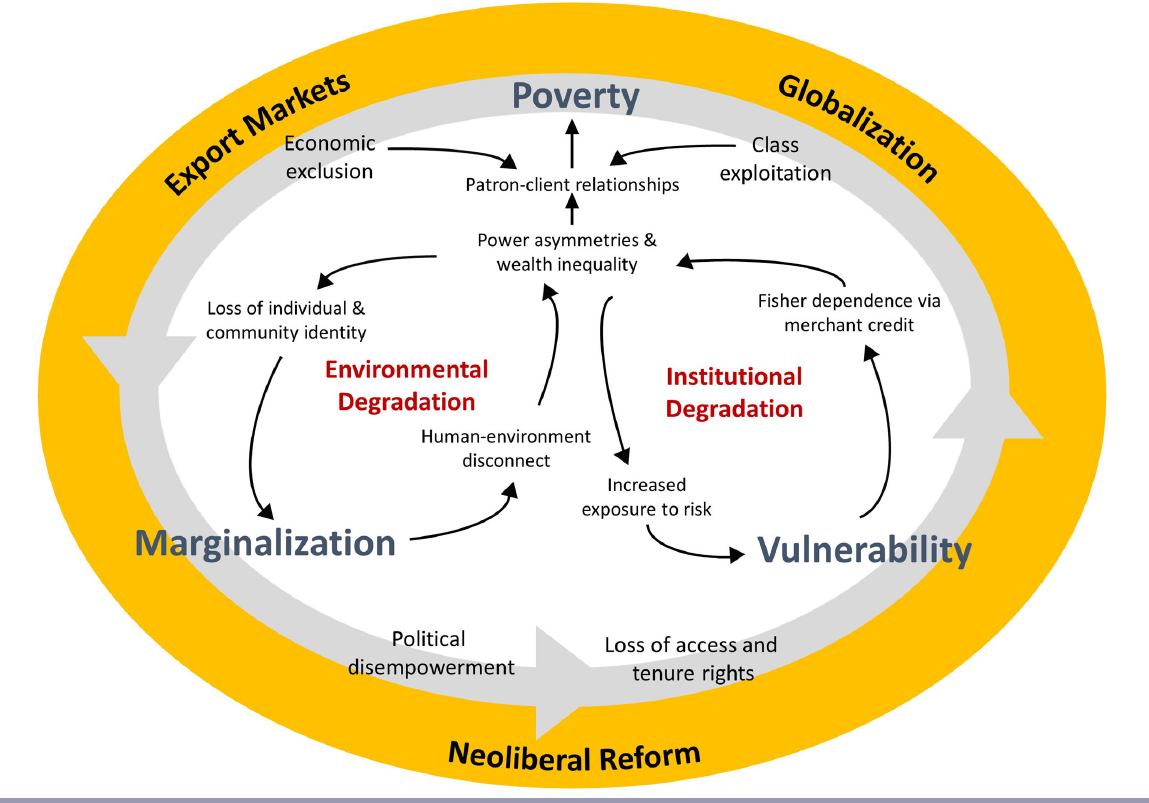
Fig. 2 . Theoretical model depicting small-scale fisheries interactions in the age of globalization. In the absence of alternatives, cross-scale interactions initiated by neoliberal reforms may represent a social-ecological trap that undermines institutional and environmental